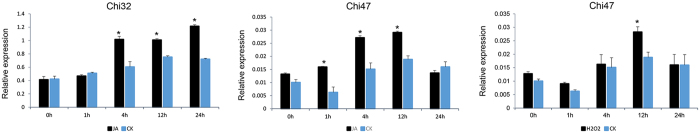
Expression patterns of two chitinase genes treated with stress-related signals in cotton.Two treatments [jasmonic acid (JA) and H2O2], and only JA were detected the induced changes of the expression levels of Chi47 and Chi32, respectively. “*”: significant difference at P < 0.05.